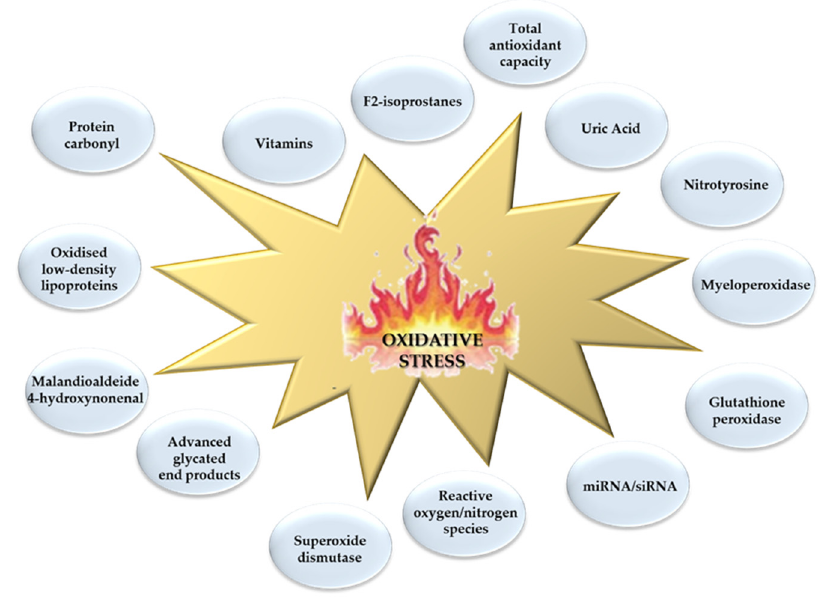
Figure 1. Main commonly measured biomarkers related to the oxidative stress multi-entity.